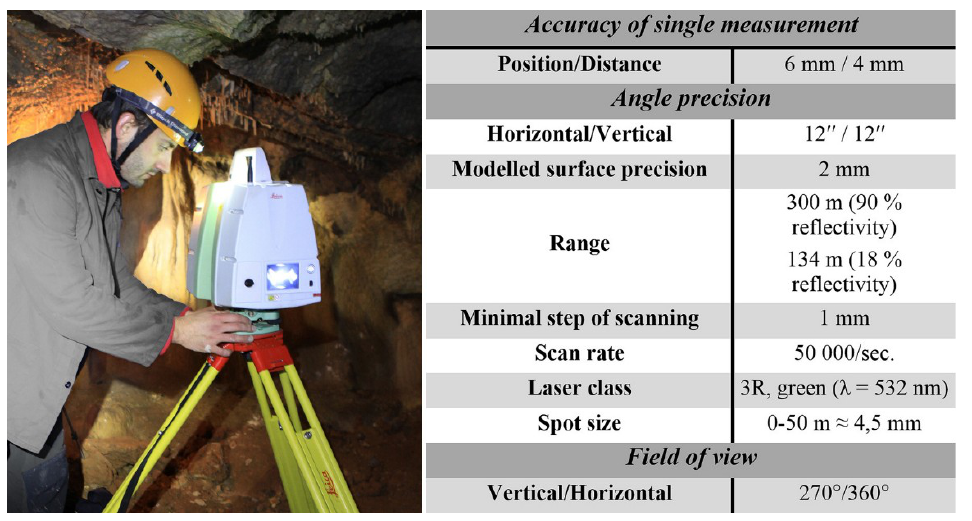
Figure 4. Leica ScanStation C10 during the survey and its technical specification.